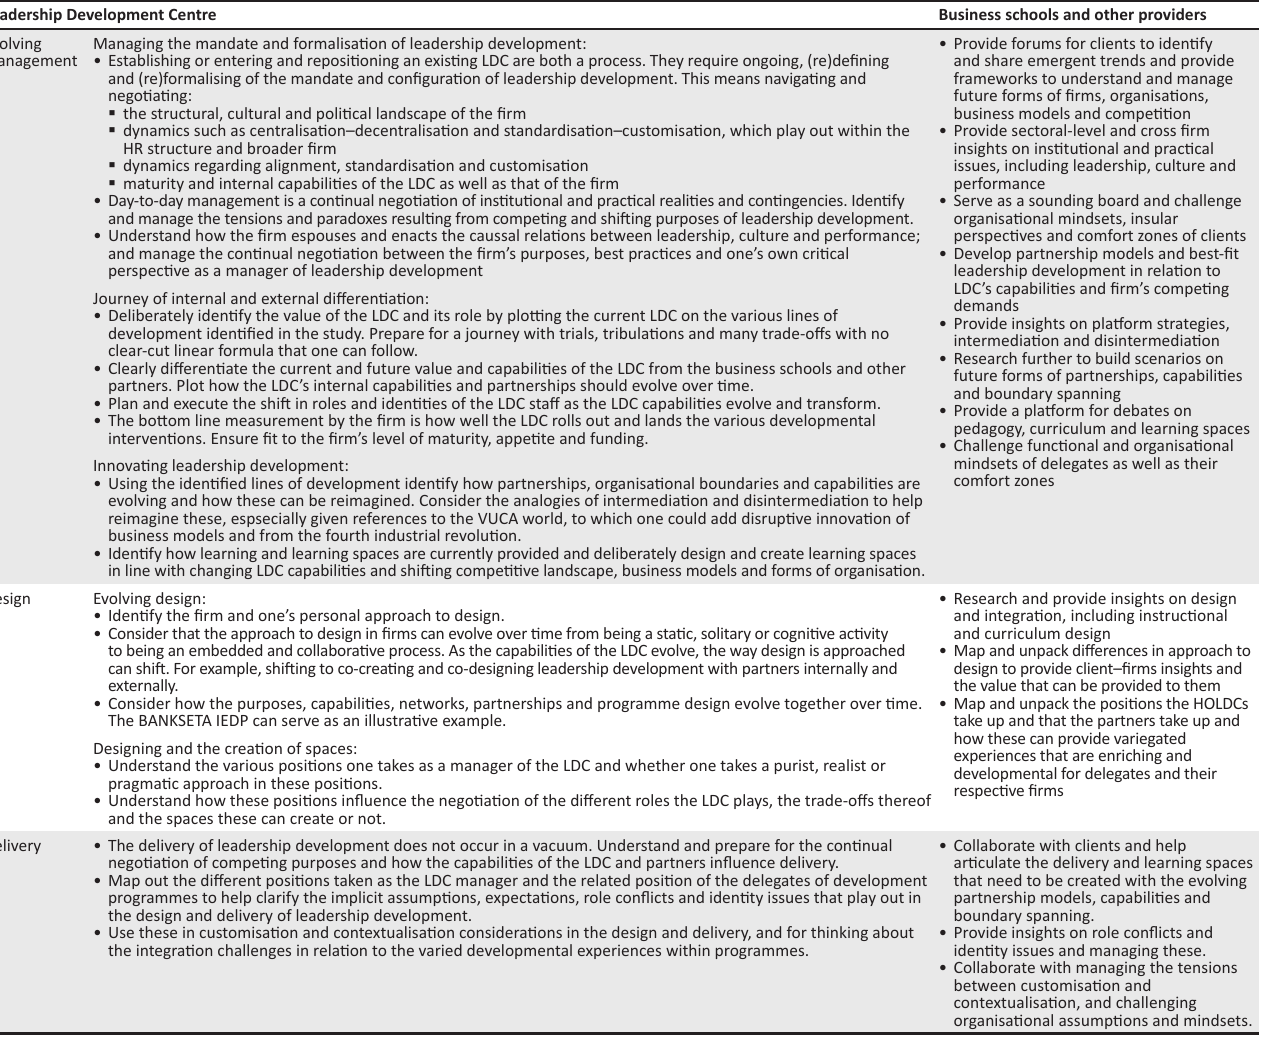
TABLE 4: Practical suggestions for Leadership Development Centres and their